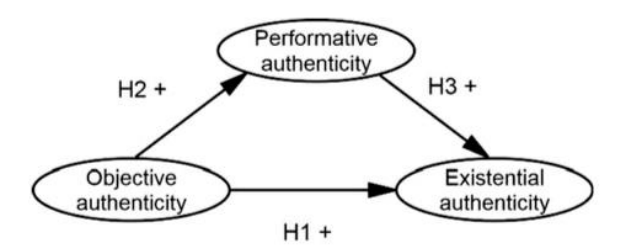
Figure 4. Conceptual Model of Perceived Authenticity (Source: Wang and Wu,